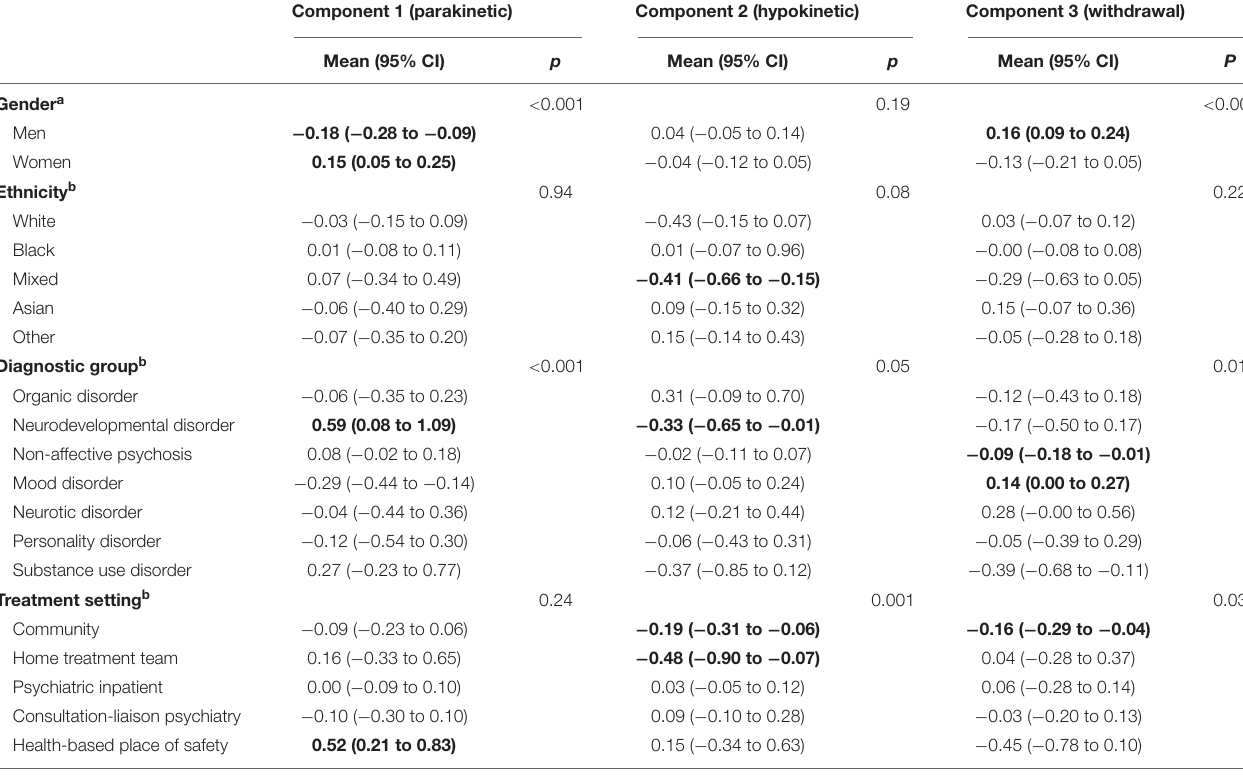
TABLE 3 | Principal component means by gender, ethnicity, diagnostic group, and treatment setting.